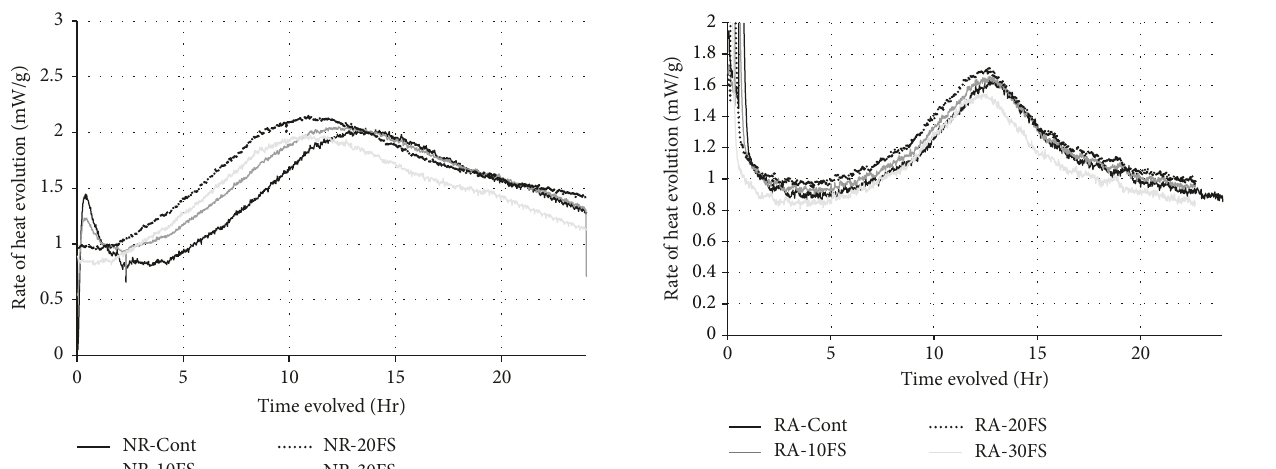
Figure 6: Heat flow curves for UHSC-FS mixtures using nonreac- tive aggregate.